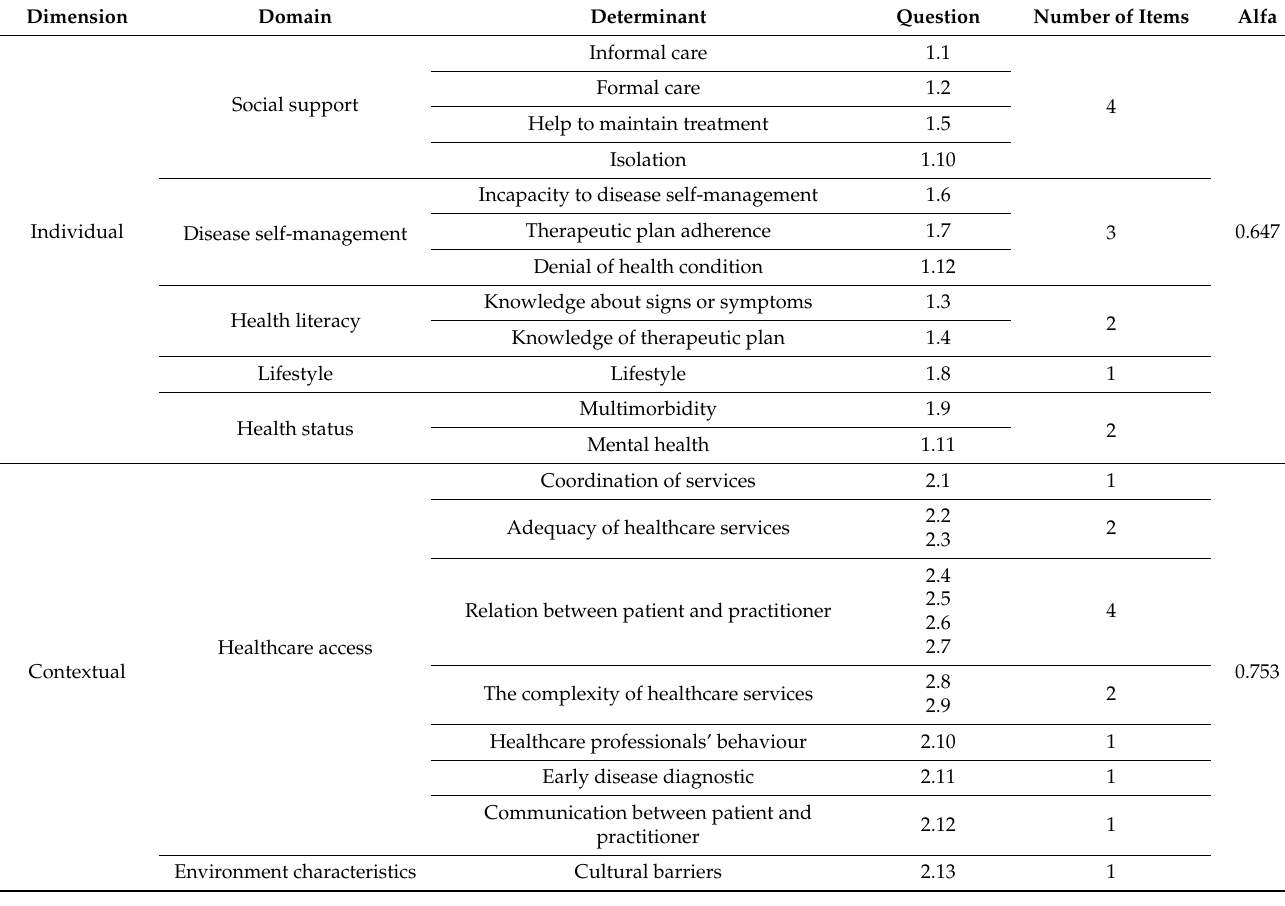
Table 5. Cronbach’s alfa.